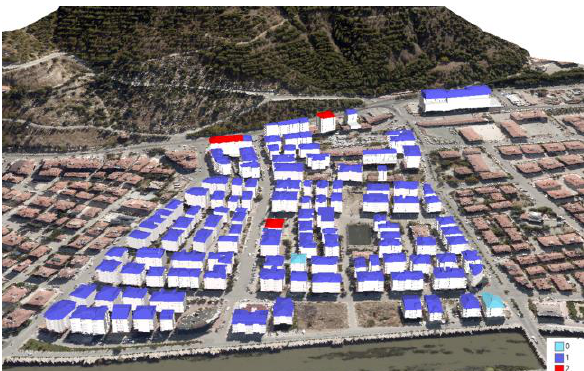
Figure 13. Classification of Storeys Above